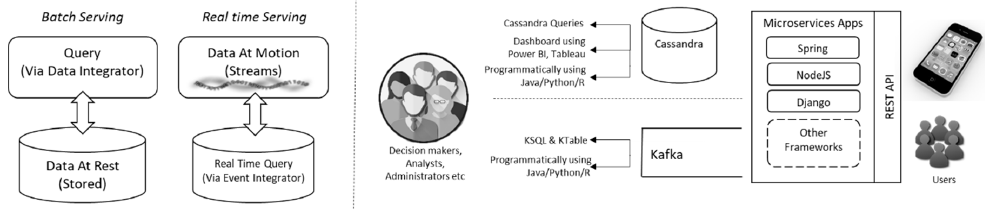
Figure 6. Serving layer of MOBDA using Apache Cassandra and Kafka.